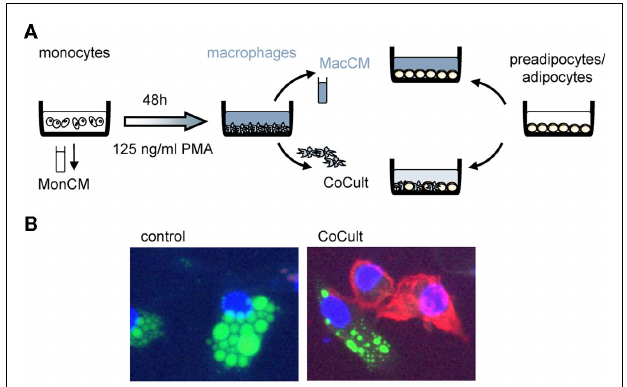
FIGURE 1 | Experimental setup. (A) We designed an experimental setup to mimic adipose tissue inflammation in vitro . HumanTHP-1 cells were either used as monocytes or differentiated into macrophages by incubation with 125ng/ml PMA (phorbol-12 myristate 13-acetate).We used monocyte-conditioned (MonCM) and macrophage-conditioned media (MacCM) which were collected for 48h in serum-free medium. In a direct co-culture system (CoCult) macrophages were directly added to cultures of human SGBS preadipocytes and adipocytes. (B) Immunofluorescence of SGBS control cultures and co-cultures of SGBS andTHP-1 macrophages stained with CD11c-PE, BODIPY, and DAPI.